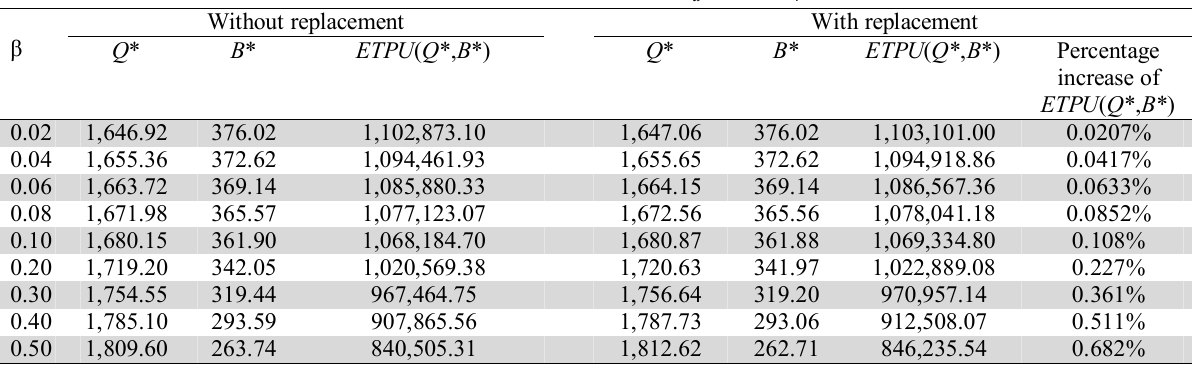
Optimal solutions when the defective probability p is uniformly distributed between 0 and β. D = 50,000, x =175,200, K =100, h = 5, b = 10, d = 0.5, c = 25, s = 50, v = 20,